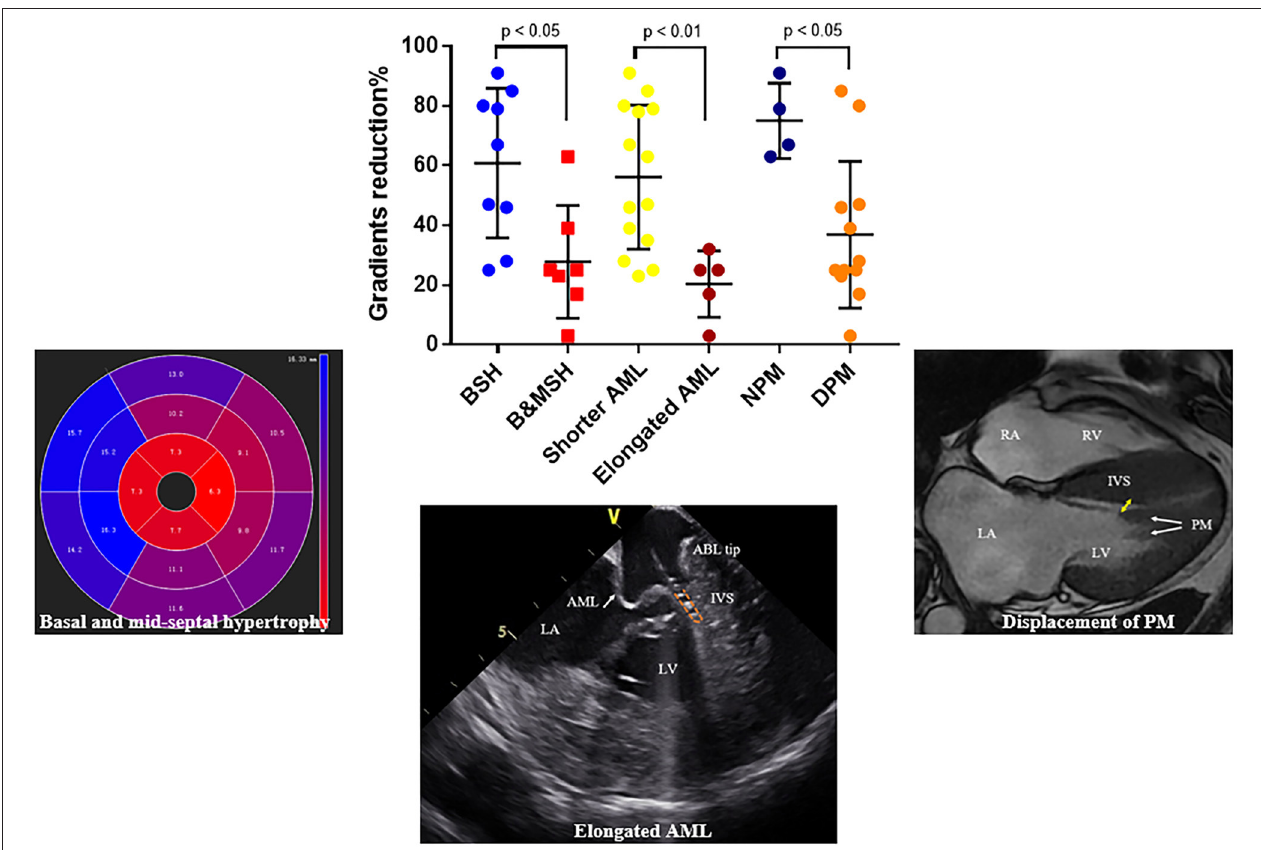
FIGURE 6 | Representative figure. Factors that influence the outcomes of endocardial radiofrequency septal ablation. Reduction of LVOT gradient is significantly higher in patients with limited basal septal hypertrophy, shorter AML and normally positioned PM, respectively. BSH, basal septal hypertrophy; B&MSH, basal and mid-septal hypertrophy; NPM, normally positioned papillary muscle; DPM, anterior displacement of papillary